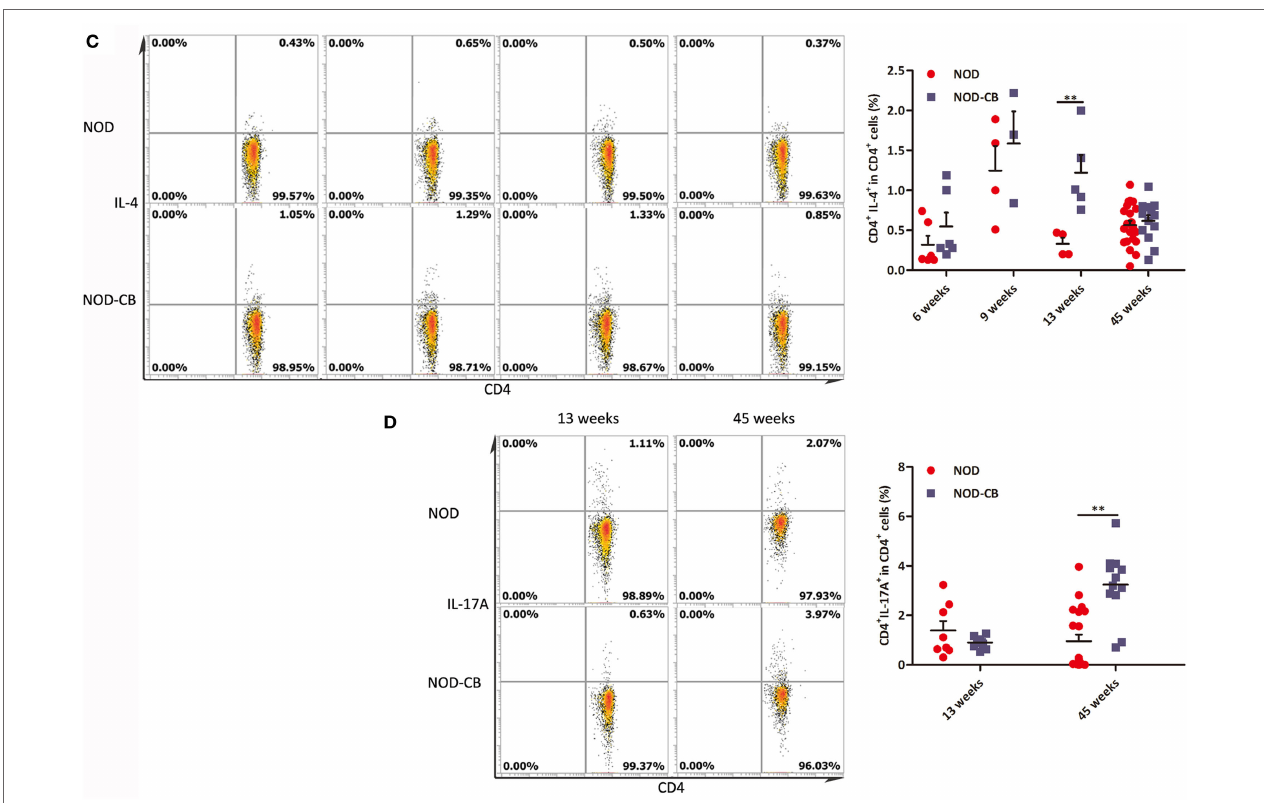
FigUre 9 | CB0313.1 changes the splenic cytokine profiles. (a) Percent CD4 + Foxp3 + cells in spleen as indicated at 6, 9, 13, and 45 weeks of age. Percent CD4 + IFN- γ + (B) CD4 + IL-4 + (c) and CD4 + IL-17A + (D) cells in spleen as indicated. Data are mean ± SEM ( n = 3–21 mice per group). *, **, *** p < 0.05, p < 0.01, p < 0.001 vs NOD control mice by t -test. The number of cells is